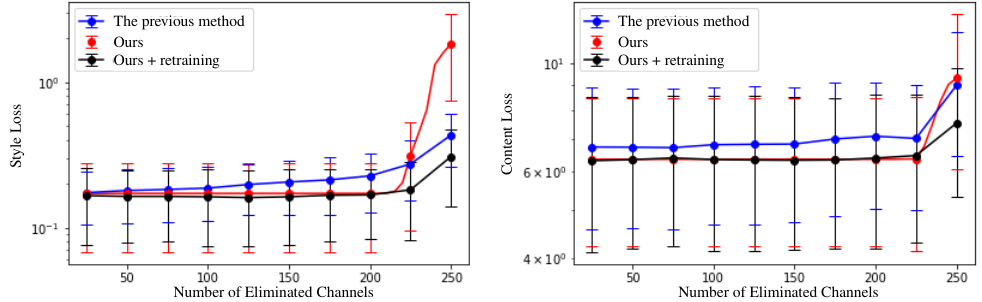
Figure 6. Loss variation corresponding to the number of eliminated channels. The blue lines are the results of the previous pruning method